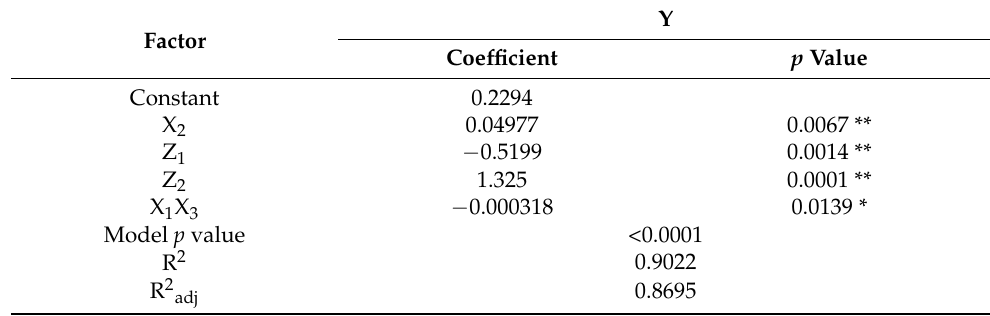
Table 9. Regression coefficient and variance analysis of the